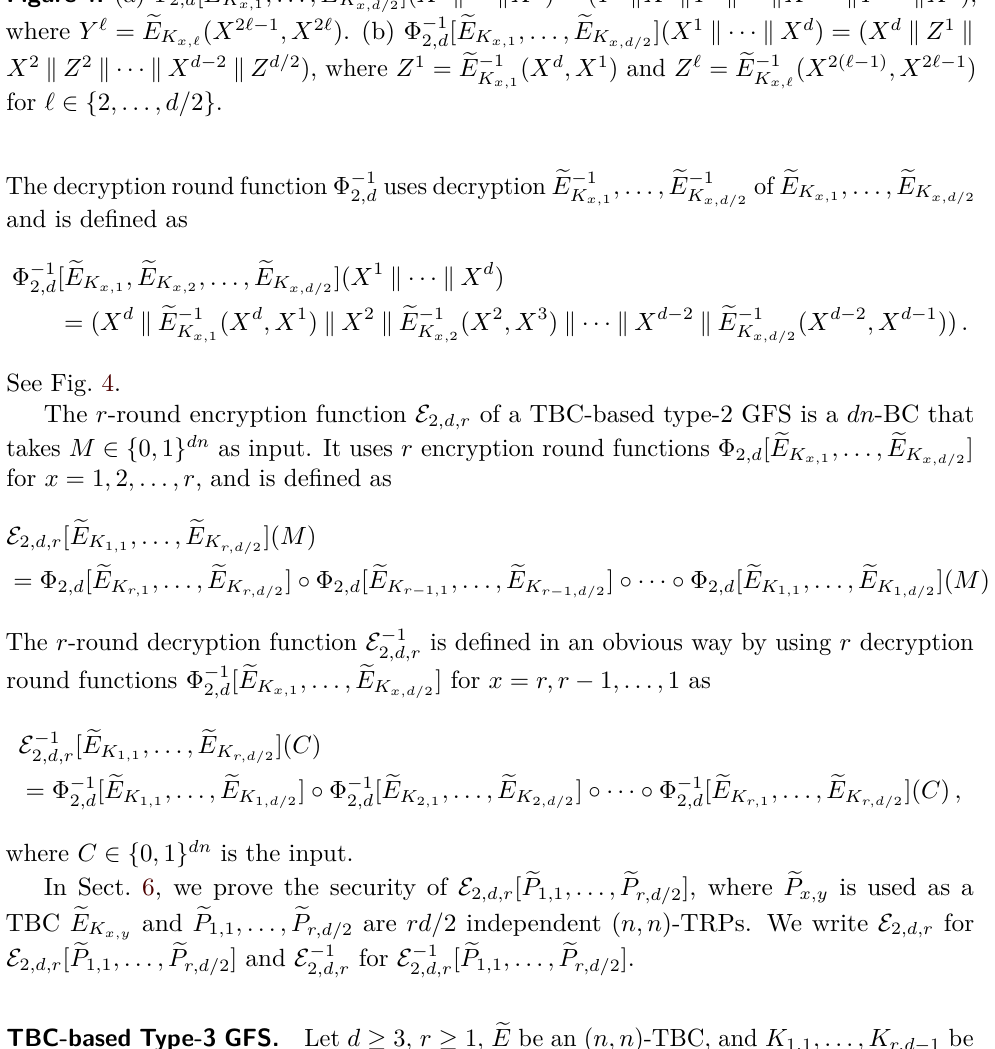
]( X 1 ∥· · ·∥ X d ) = ( Y 1 ∥ X 3 ∥ Y 2 ∥· · ·∥ X d − 1 ∥ Y d/ 2 ∥ X 1 , . . . , e E K x, 1 x,d/ 2